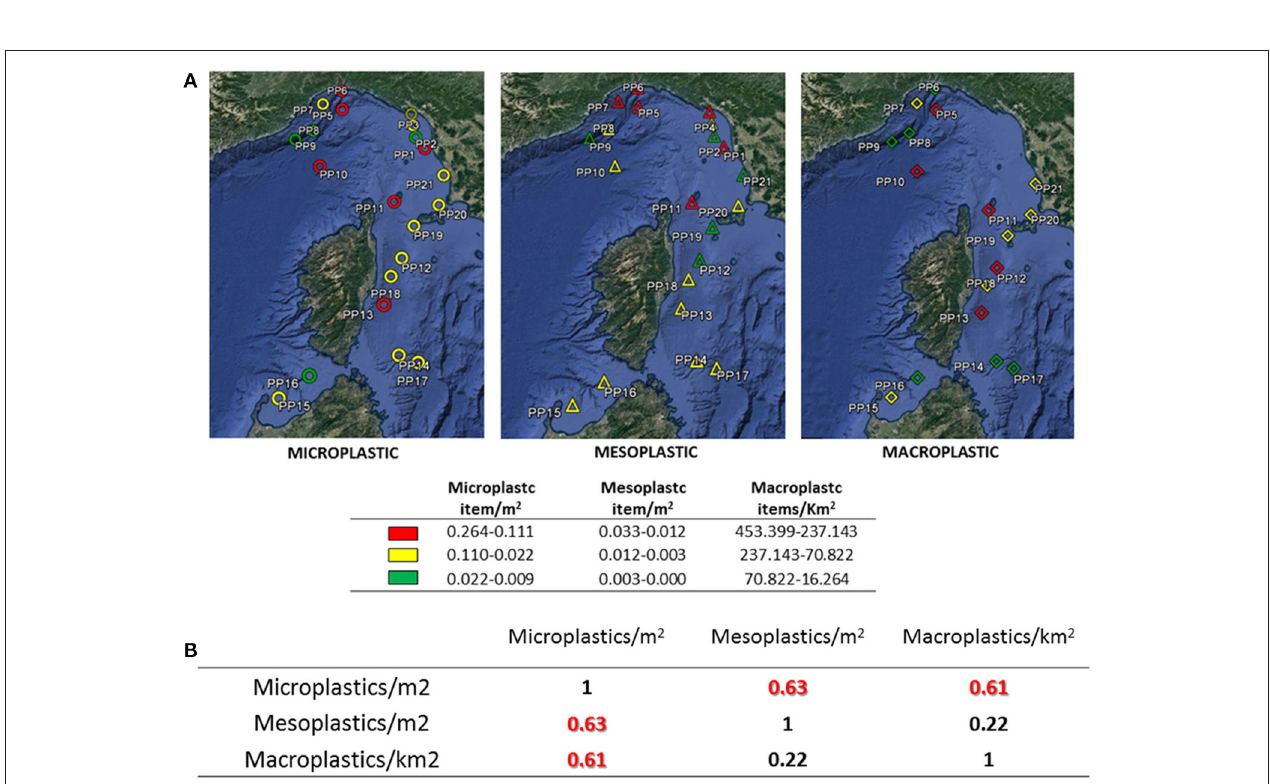
FIGURE 4 | Spatial distribution of microplastics, mesoplastics and macroplastics in the Pelagos Sanctuary during the Plastic Pelagos survey. (A) The different colors of the sampling sites represent the relative concentration of items/m 2 (microplastics and mesoplastics) and items/km 2 (macroplastics). Red symbols are values ≥ 75th percentile; yellow are values < 75th and ≥ 25th percentile; green are values < 25th percentile; map produced using the Google Earth version 7.1.5.1557 open source software; (B) Correlation between micro-, meso-, and macroplastic in the Pelagos Sanctuary.